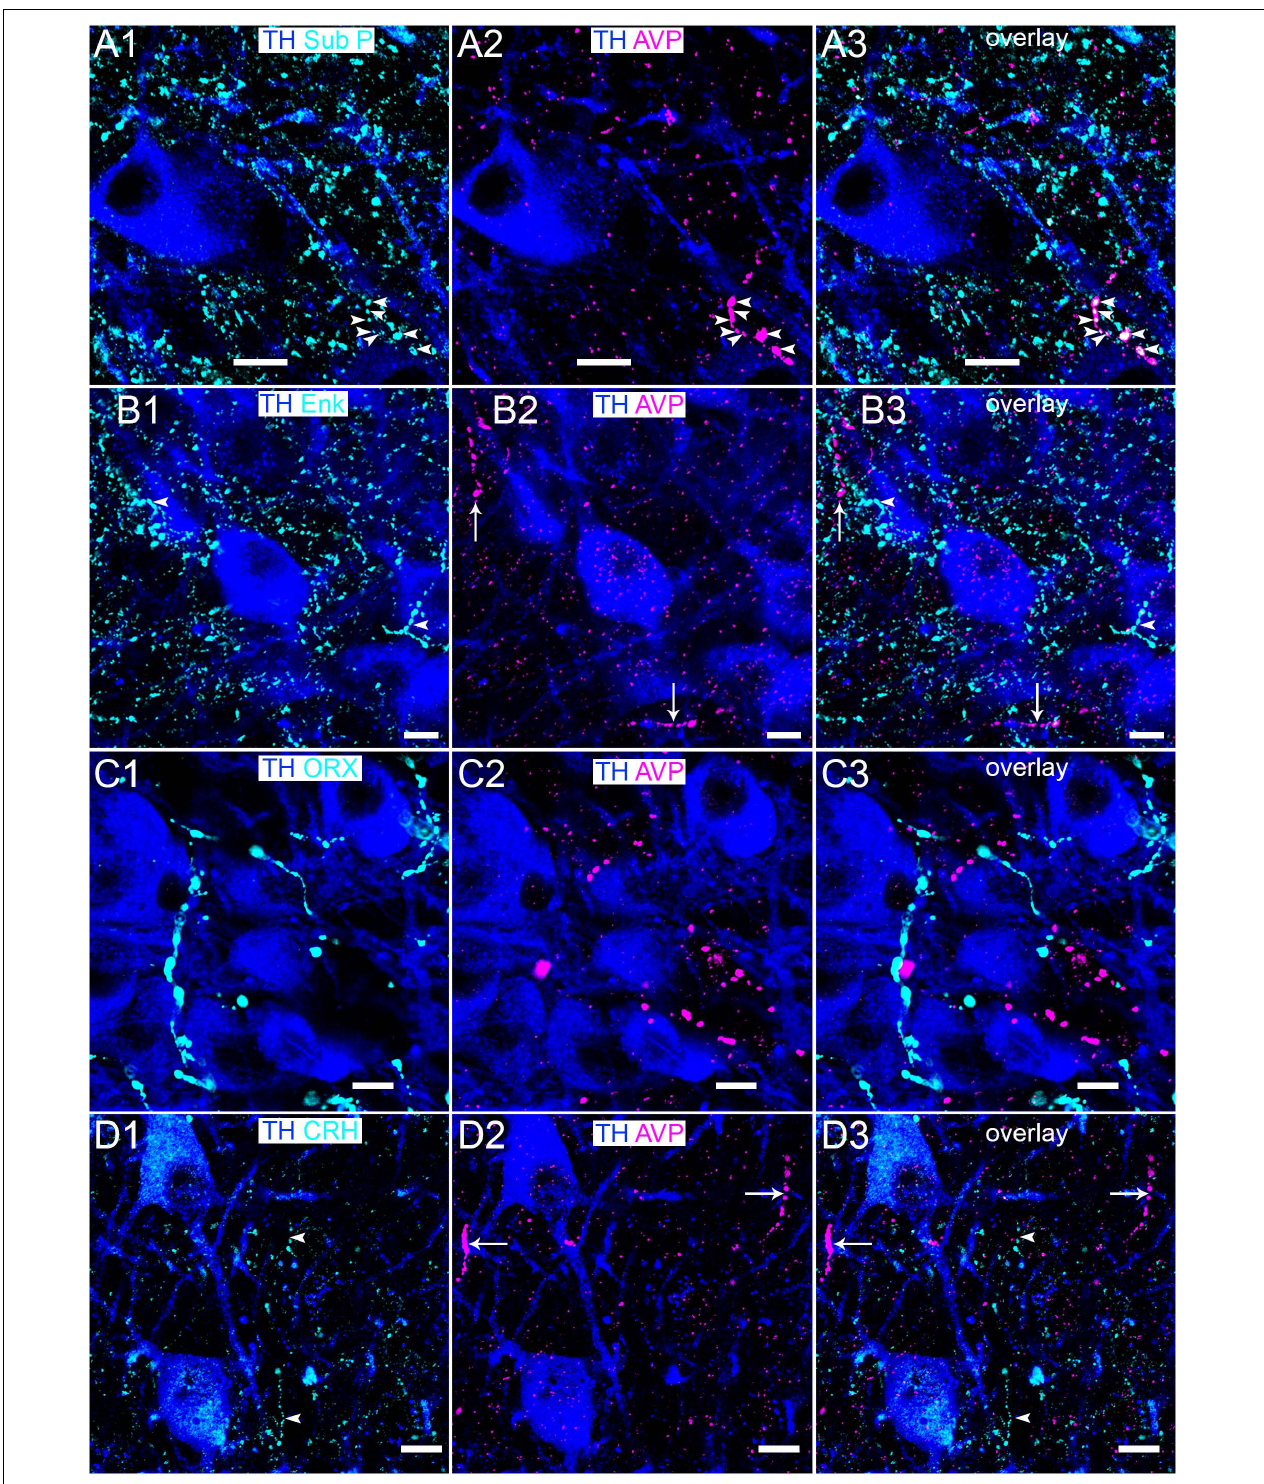
FIGURE 8 | Association of AVP with LC neuromodulatory afferent systems. (A1) Immunoreactivity for TH (blue) and substance P (Sub P) (cyan). In the same field of view, (A2) immunoreactivity of TH with AVP. (A3) Is an overlay of (A1,A2) showing isolated instances of colocalization of immunoreactivity for substance P and AVP (arrowheads). Immunoreactivity for TH with (B1) enkephalin (ENK), (C1) orexin A (ORX) and (D1) CRH, with arrowheads highlighting a subset of varicosities in (B1,D1) . (B2,C2,D2) Show immunoreactivity of TH with AVP in the corresponding fields of view, with AVP immunopositive varicosities highlighted by arrows in (B2,D2) . (B3,C3,D3) Are overlays of (B,C,D1,D2) showing the lack of colocalization of AVP signal with that of the corresponding neuropeptides. Scale bars 10 µ m.